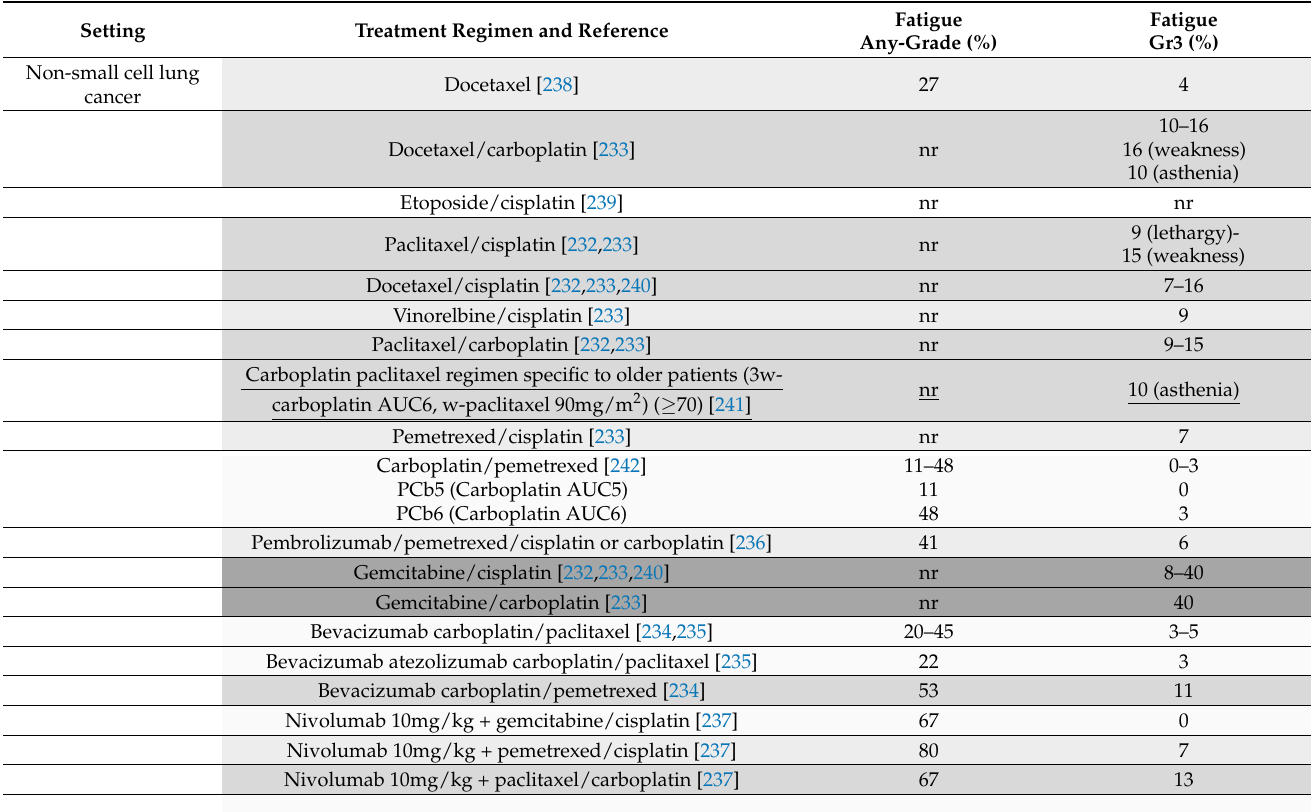
Table 5. Fatigue events in the most common anticancer regimens for lung